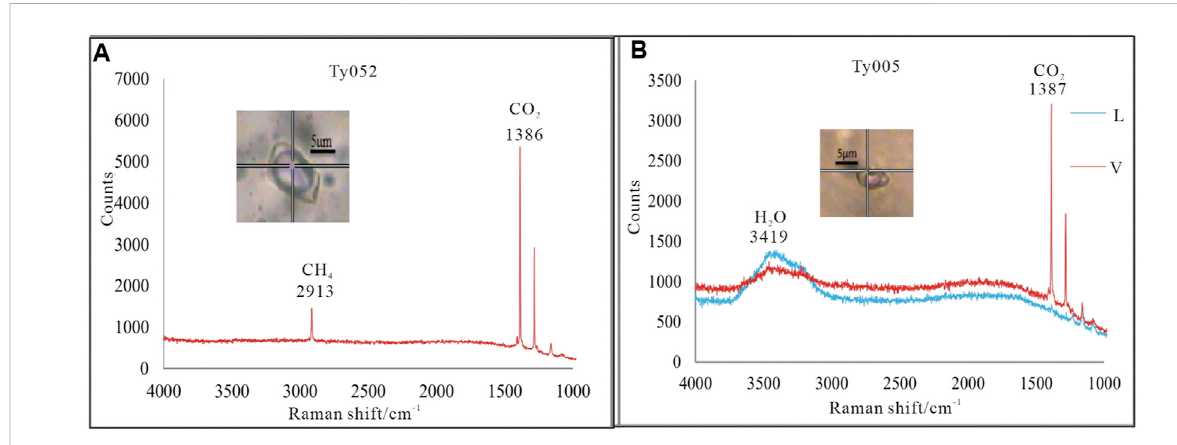
FIGURE 8 LaserRamanspectraofinclusionsintheDongtongyugolddeposit. (A) -H 2 O-CO 2 typeinclusioninStage3,TY052; (B) -H 2 O-CO 2 typeinclusion in Stage 2,